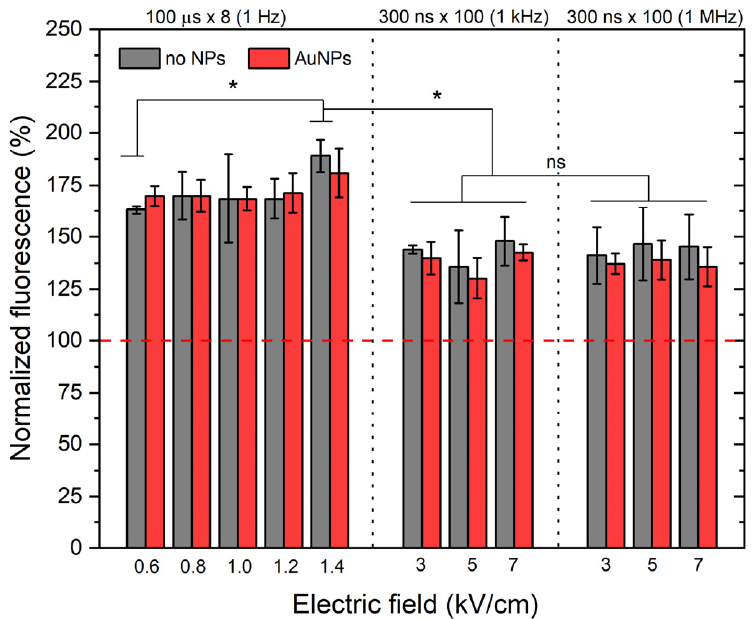
Figure 10. Generation of ROS during electroporation-based treatment. Asterisk (*) corresponds to statistically significant difference ( p < 0.05;